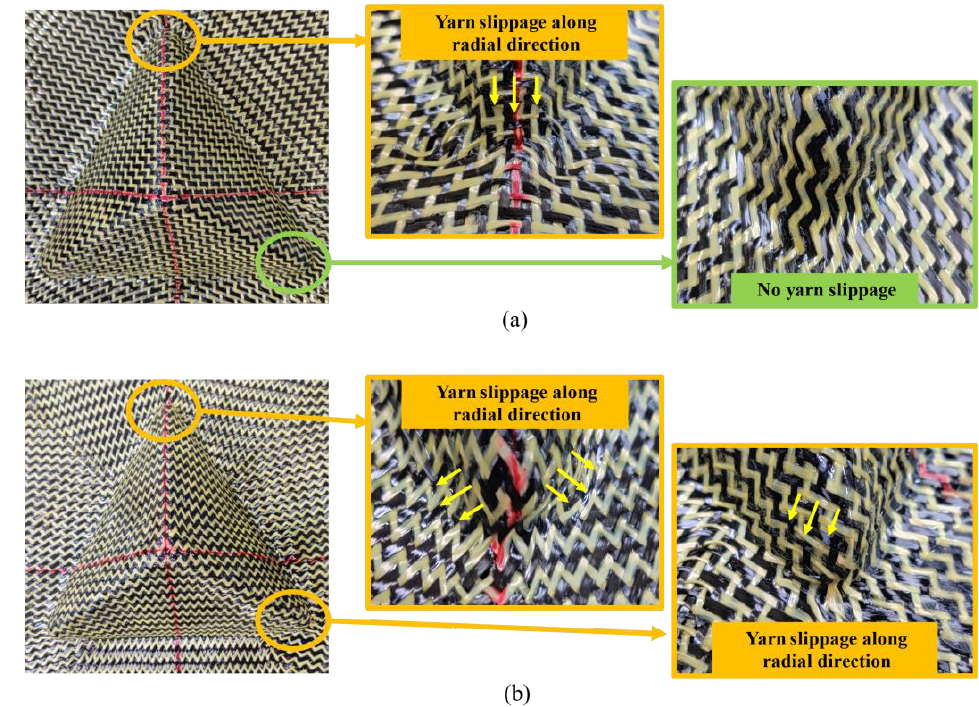
Figure 15. Yarn slippage along radial direction occurred at the bottom corner of the tetrahedral preform: ( a ) tetrahedral preform with 0°/90° initial yarn orientation; ( b ) tetrahedral preform with ±45° initial yarn orientation.